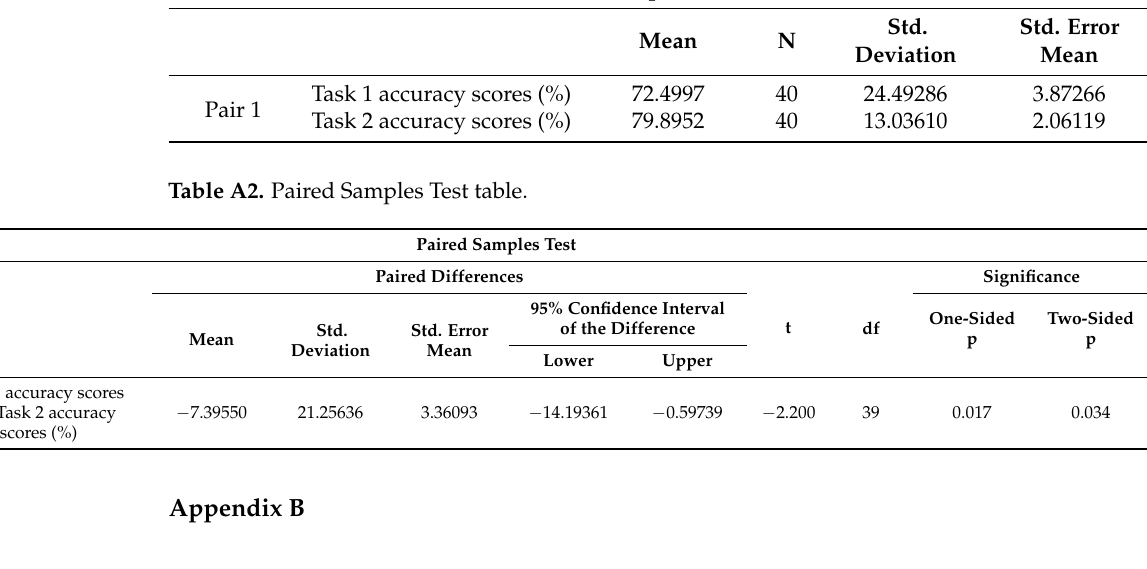
Table A3. Kruskal–Wallis Test result for Task 1.